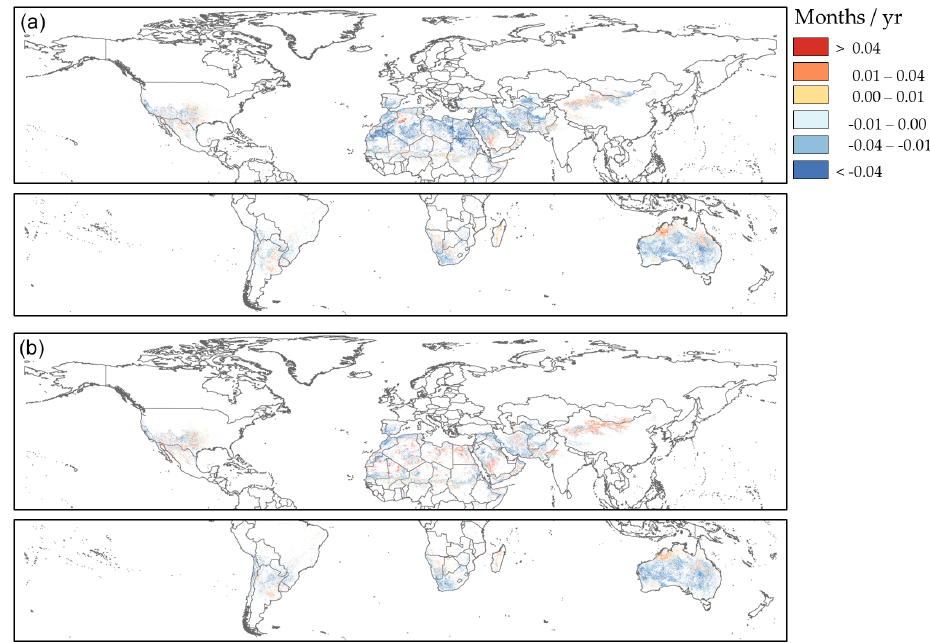
Figure 9. The change in timing of the normalized difference vegetation index (NDVI) per year (yr) from the (a) Global Inventory Modeling and Mapping Studies (GIMMS) and (b) Vegetation Index and Phenology Lab (VIP) records. The upper panals represent the Northern Hemisphere (30-year change) and the lower panels represent the Southern Hemisphere (29-year change). Negative values indicate earlier green-up/scenence, while positive values indicate later green-up/scenence. The trends have been masked for significance ≤